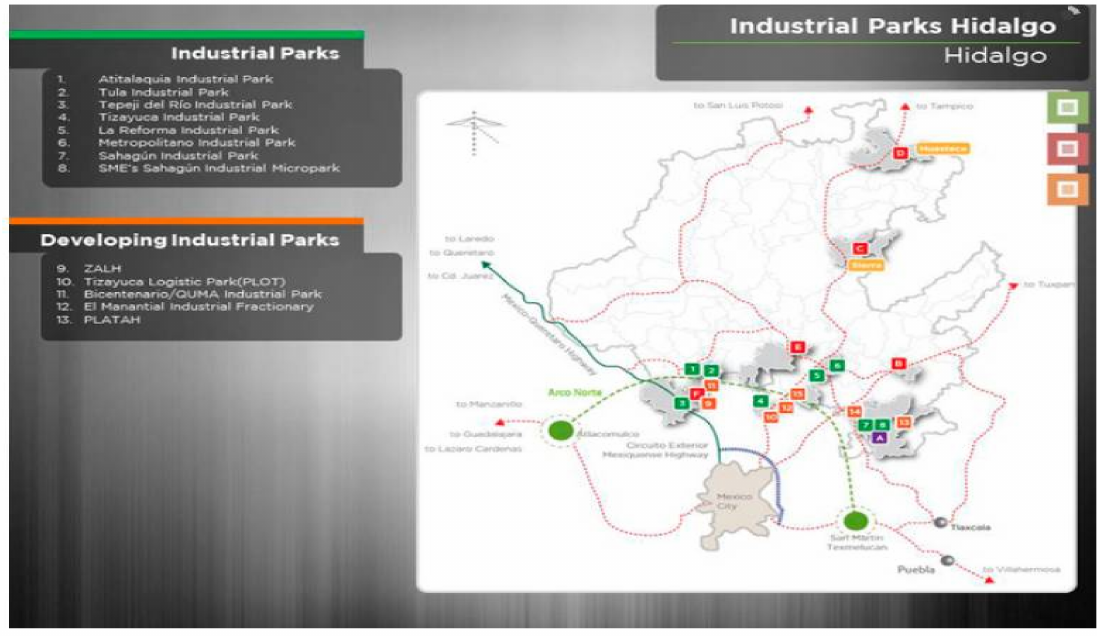
Figure 2. Industrial facilities in the state of Hidalgo, Mexico. Corporaci ó n de Fomento de Infraestructura Industrial